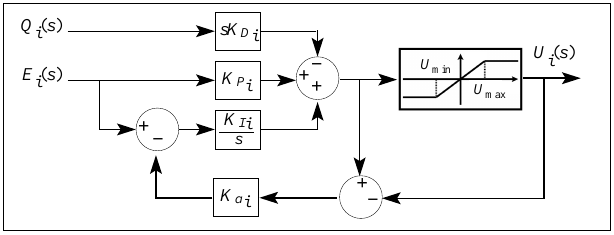
Figure 7. Block diagram of the PID controller with anti-windup